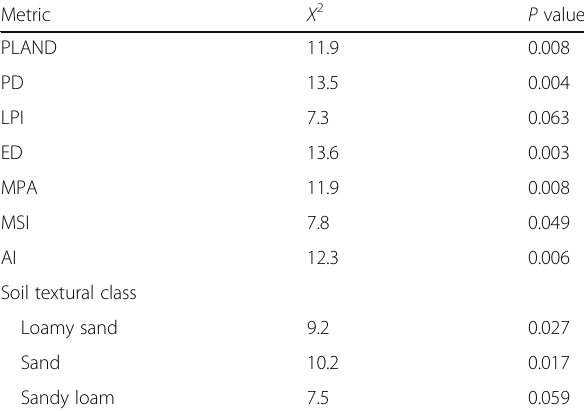
Table 2 Results of the Kruskal – Wallis one-way variance analysis for landscape metrics and soil textural classes